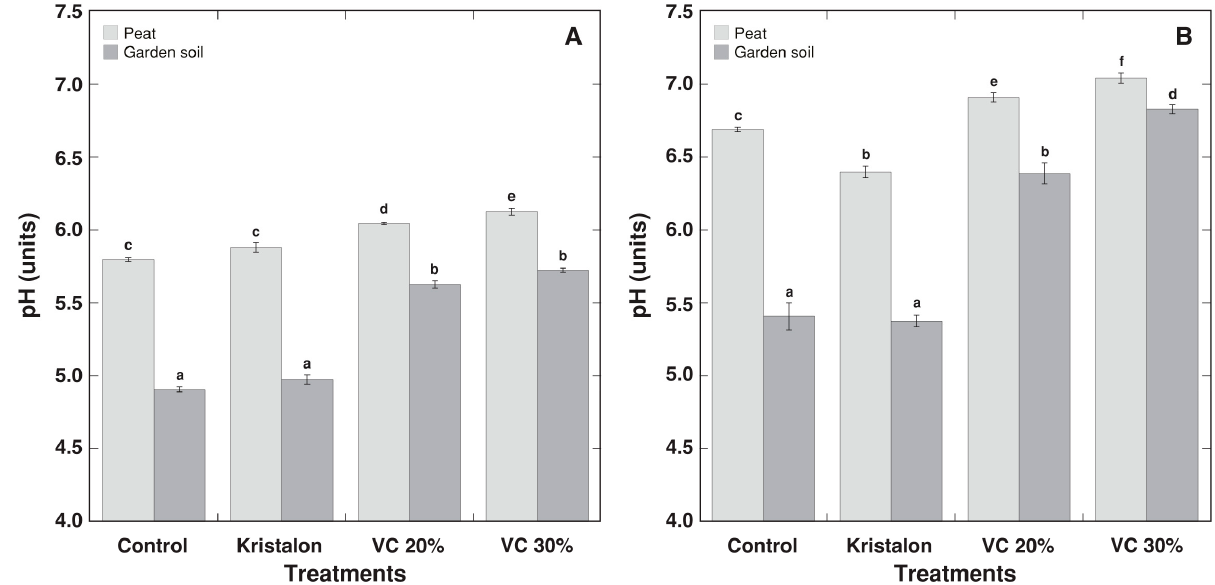
Figure 2. Effect of mineral fertilizer (Kristalon) and amendment with vermicompost (VC) at a 20% and 30% ( v/v ) rate on